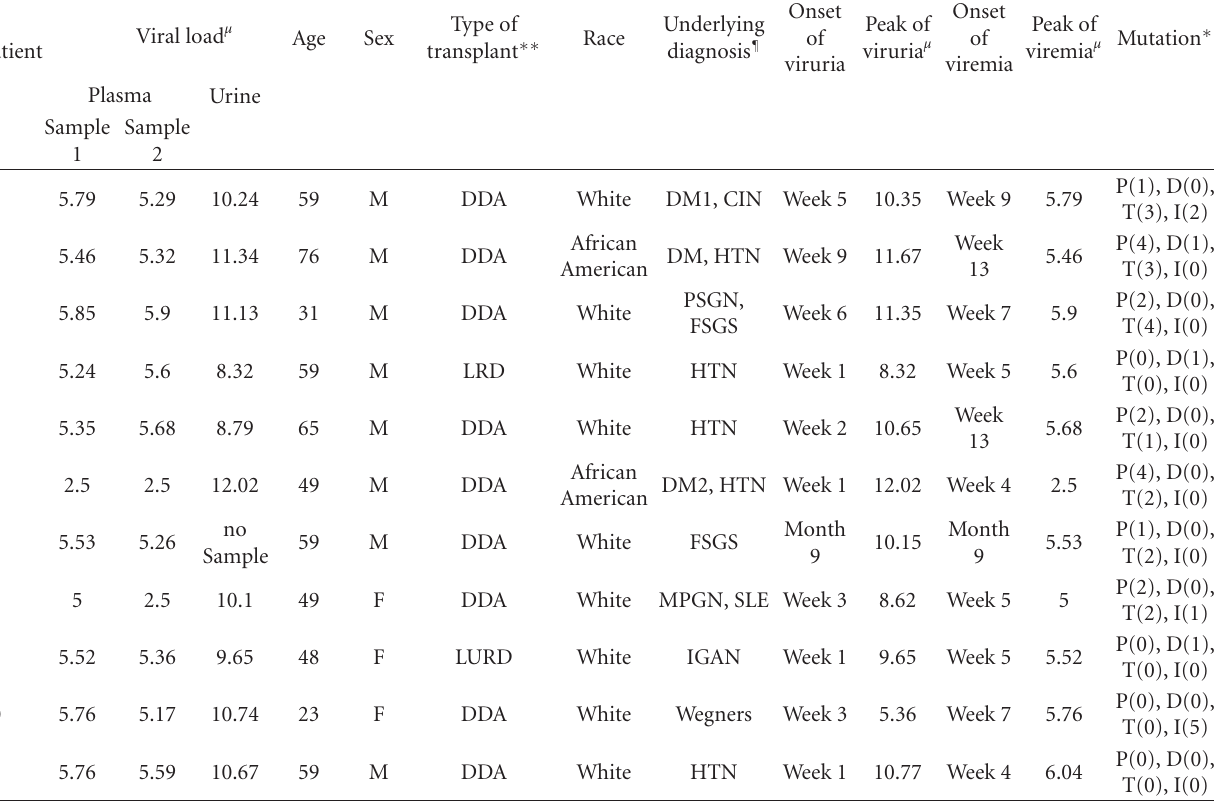
Table 1: Basic demographic data of the patients and sample